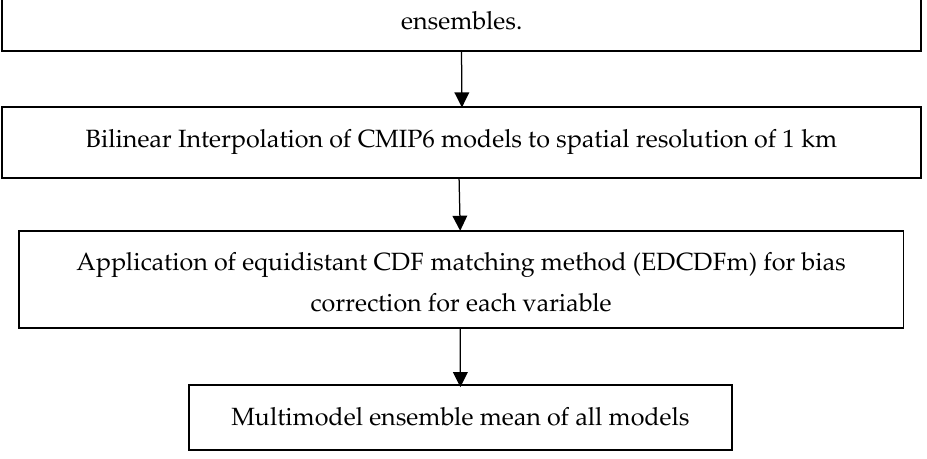
Figure 5. Outline of bias correction steps with applied methods.